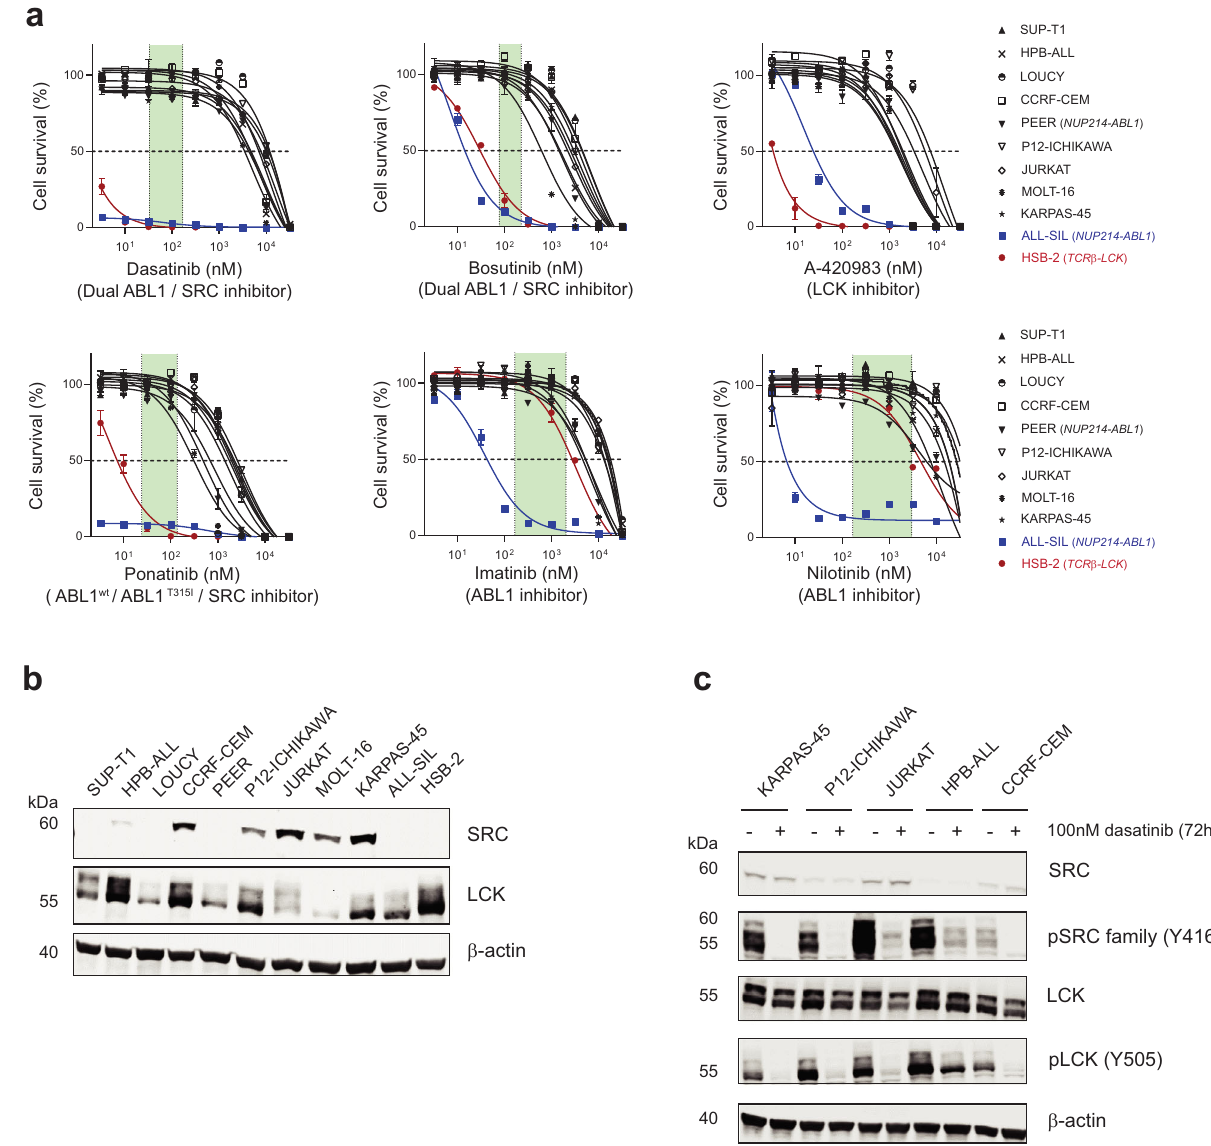
Fig. 3 T-ALL cell lines show limited sensitivity to SFKs inhibition in vitro. a Dose-response curves of SFKs inhibitors treatment in 11 T-ALL cell lines. Cells were treated with increasing concentrations of different SFKs inhibitors: dasatinib, bosutinib, A-420983, ponatinib, imatinib and nilotinib (3.2 nM – 32 µ M range) in duplo and cell viability was assessed after 72 h using the ATPLite assay (PerkinElmer). Cell survival was calculated in comparison to the untreated control. Each point represents the mean and standard deviation of the duplicate. The green box shows the range of clinical concentrations either derived from pharmacodynamics studies or based on drug dosages used in current clinical trials 52 – 55 . b Western blot analysis showing LCK and SRC expression in untreated T-ALL cell lines. 30 µ g of protein input was used for each sample. The image is representative of two independent experiments. c Western blot analysis upon dasatinib treatment. Cell lines expressing high levels of LCK and/or SRC were treated with 100 nM dasatinib for 72 h and 30 µ g of protein was used per sample. The image is representative of two independent experiments. Source data are provided as a Source Data fi